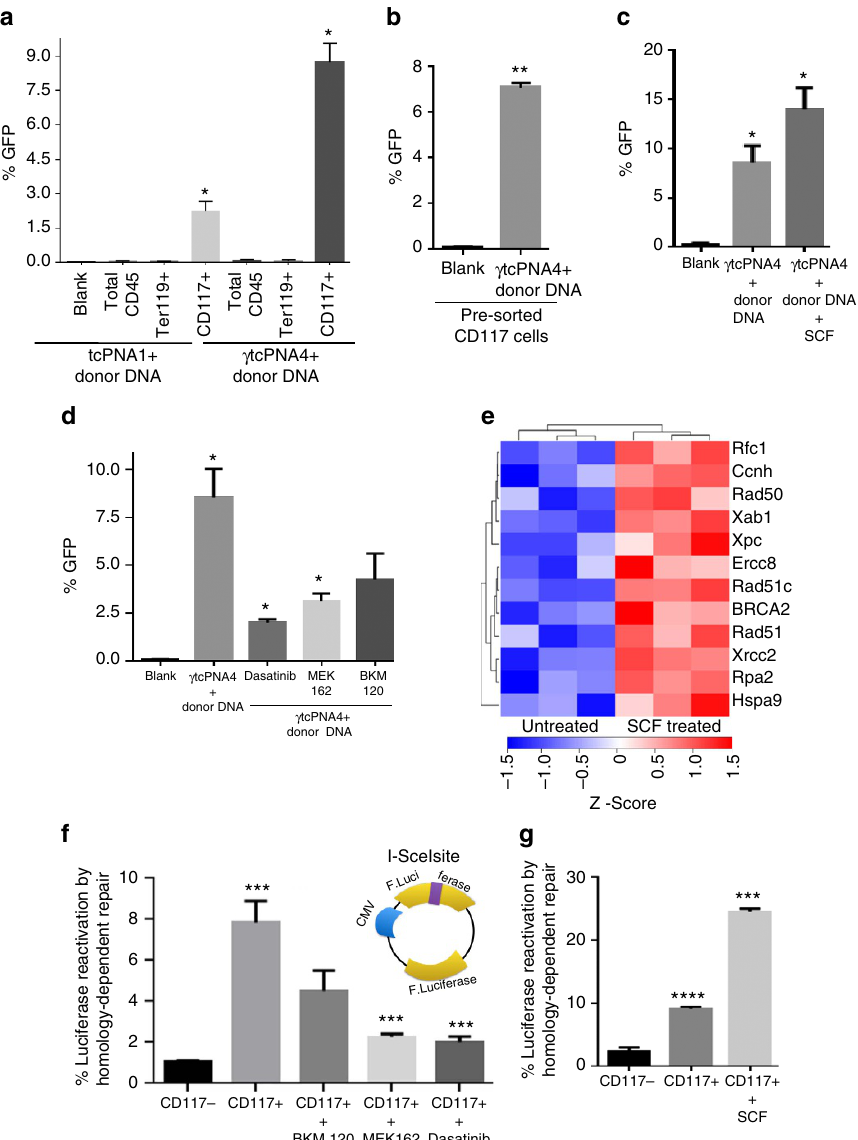
Figure 2 | The SCF/c-Kit þ pathway promotes gene editing and DNA repair. ( a ) %GFP expression in treated mouse BM cells expressing the indicated cell surface markers. Total BM was treated with NPs containing either tcPNA1/donor DNA or g tcPNA4/donor DNA, cells were stained using antibodies specific for the indicated markers and assayed by flow cytometry for marker and GFP expression. Data are mean ± s.e.m, n ¼ 3; statistical analysis by Student’s t -test, * P o 0.05. ( b ) %GFP expression in pre-sorted CD117 (c-Kit þ ) cells treated with either NPs carrying g tcPNAs and donor DNAs or blank NPs. Data are mean ± s.e.m., n ¼ 3; statistical analysis by Student’s t -test, ** P o 0.005. ( c ) %GFP expression in pre-sorted CD117 þ cells treated with NPs containing g tcPNA4/donor DNA with or without prior treatment with the c-Kit ligand, SCF. Data are mean ± s.e.m., n ¼ 3; statistical analysis by Student’s t -test, * P o 0.05. ( d ) %GFP expression in pre-sorted CD117 þ cells treated with NPs containing g tcPNA4/donor DNA in the presence or absence of c-Kit pathway kinase inhibitors: dasatinib (inhibits c-Kit), MEK162 (inhibits MEK, MEK) and BKM120 (inhibits phosphatidylinositol-3-kinase). Data are mean ± s.e.m, n ¼ 3; statistical analysis by Student’s t -test, * P o 0.05. ( e ) Heat map showing upregulated genes involved in DNA repair in CD117 þ cells with or without SCF treatment; rows are clustered by Euclidean distance measure. ( f ) Reporter gene assay for HDR activity in CD117 cells in the presence or absence of c-Kit pathway kinase inhibitors: dasatinib, MEK162 and BKM120 (as above). Inset shows diagram of the luciferase reporter assay for repair of a nuclease-indcued DSB by HDR. Luciferase expression occurs only after homologous recombination and is scored as % reactivation of the DSB-damaged plasmid, normalized to a transfection control. Data are mean ± s.e.m., n ¼ 3; statistical analysis by Student’s t -test, *** P o 0.005. ( g ) HDR assay in CD117 þ cells with or without the addition of SCF. Data are shown as mean ± s.e.m., n ¼ 3; statistical analysis by Student’s t -test, *** P o 0.005 and **** P o component of the SCF effect on DNA repair genes could be an indirect effect of cell cycle changes.